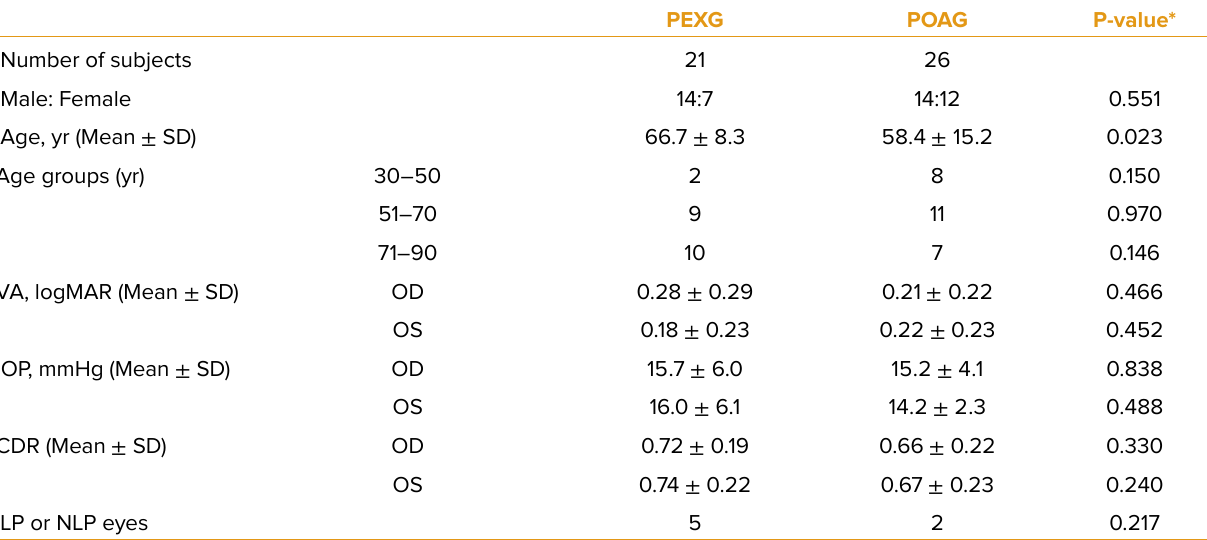
Table 1. Baseline clinical characteristics of patients included in the study.